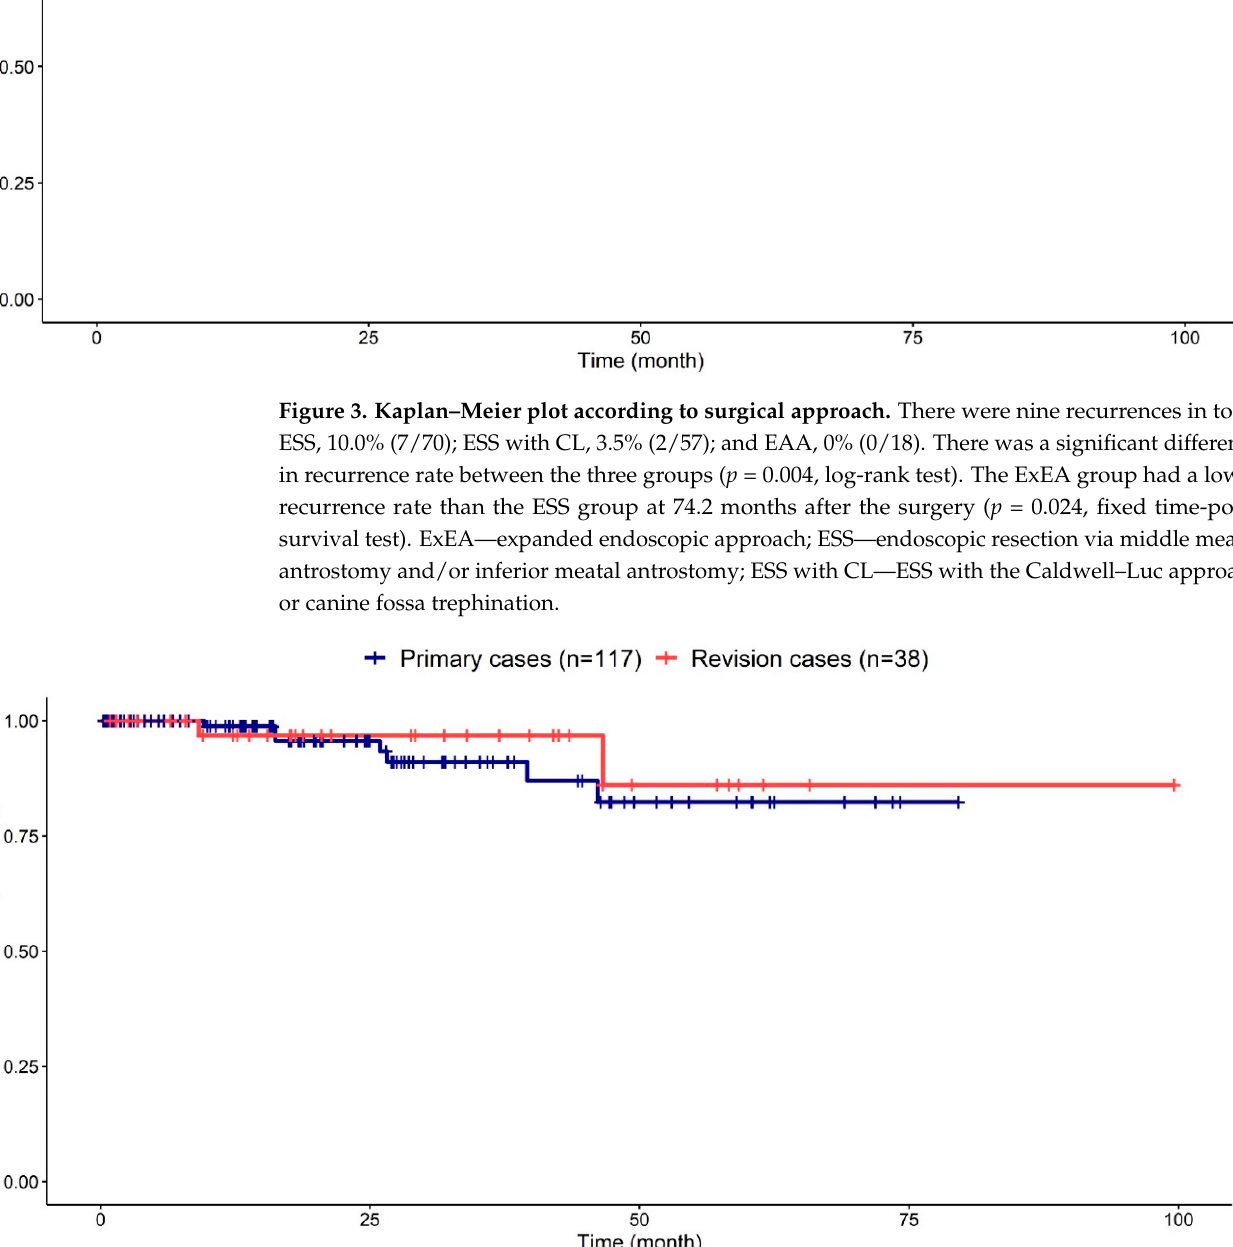
Figure 5. Kaplan–Meier plot for the subgroup analysis of primary cases. There were seven recur- rences among the primary cases: ESS, 10.2% (6/59); ESS with CL, 3.0% (1/33); and ExEA, 0% (0/25). There were significant differences in recurrence rates between the three groups ( p = 0.010, log-rank test). The ExEA group had a lower recurrence rate than the ESS group at 74.2 months after surgery ( p = 0.035, fixed time-point survival test). ExEA—expanded endoscopic approach; ESS—endoscopic